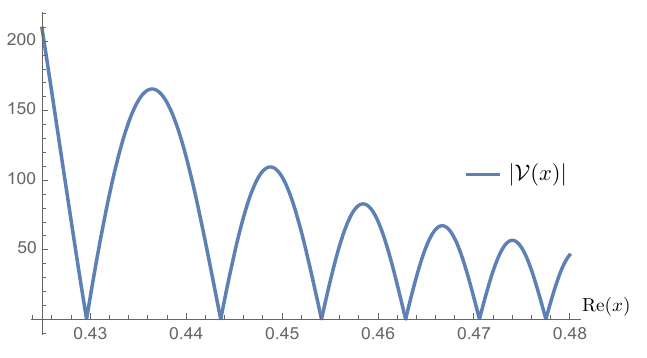
( x; c ) along a path on the complex x plane jV j